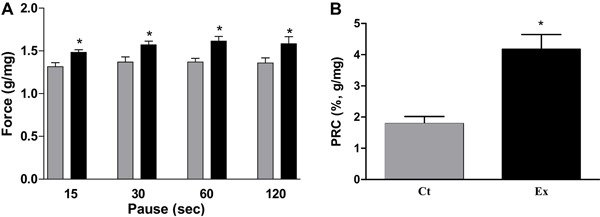
Effects of post-rest potentiation (A) and post-rest
contraction (PRC) (B) on force developed in isolated left
ventricle papillary muscles from control (Ct, n=16) and exercised (Ex, n=16)
spontaneously hypertensive rats (SHR). Gray bars: control; black bars:
exercise. Results are reported as means±SE. *P<0.05, compared to control
(Student’s t-test).